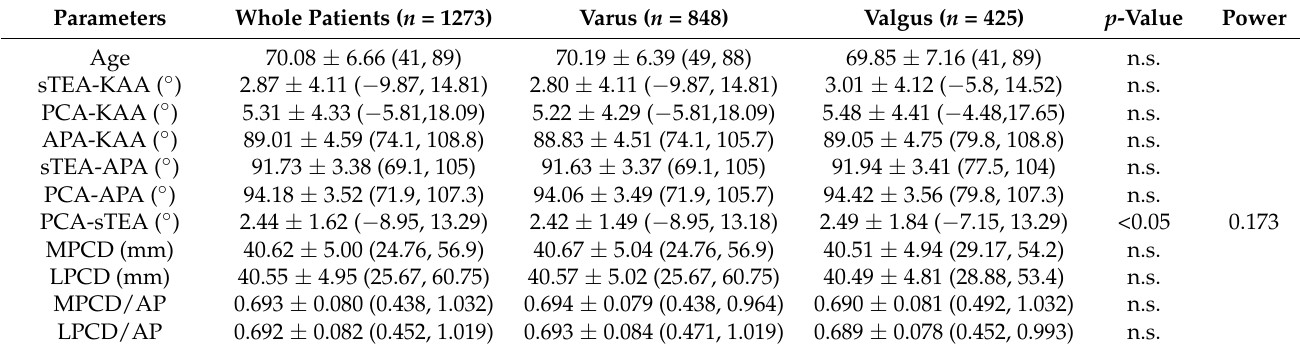
Table 2. Comparison of measurements according to the lower limb